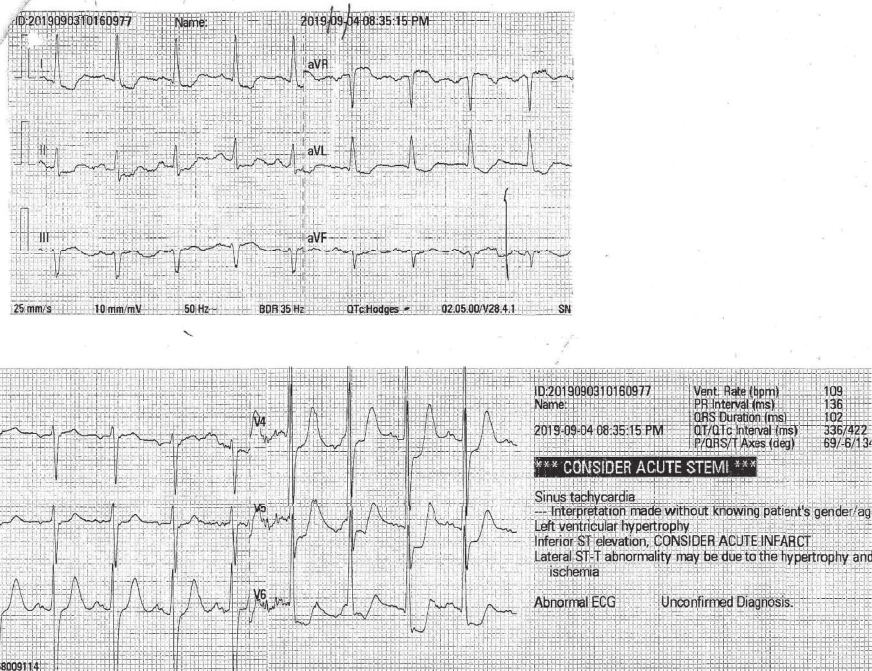
Figure 1: Electrocardiogram taken immediately after admission, showing ST-segment depression in the chest leads, V4–V6.